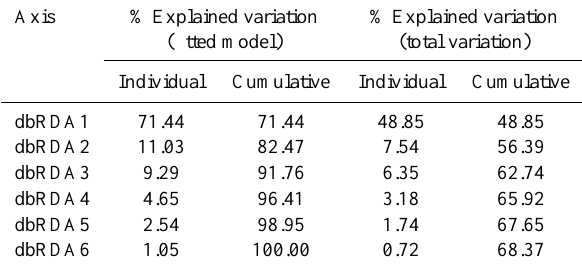
Table 2. Results of distance-based multivariate linear model (Dis- tLM) for bacterial community composition in epipelagic and deep water layers, showing the % variation explained by individual axes. The first two columns relate to the percentage explained out of the fitted model (individuated with the DistLM analysis). The second two columns relate to the percentage explained out of the total vari- ation in the resemblance matrix used to build up the DistLM